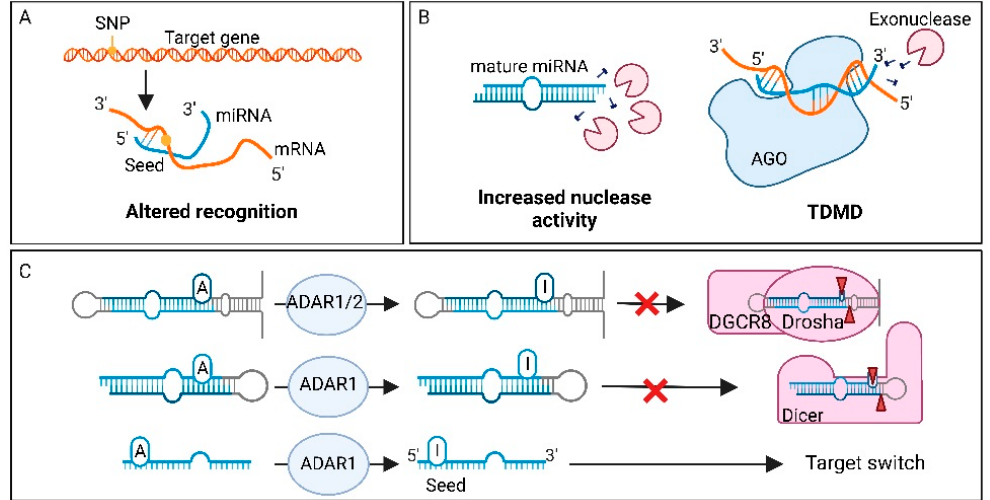
Figure 5. microRNA dysregulation in cancer through target gene modifications, and factors affecting microRNA degradation and microRNA editing. ( A ) A mutation in the microRNA (miRNA) recognition site of a target gene can result in multiple changes; the target can become undetectable for the miRNA, the mutation might change the degree of repression or make a target recognizable for miRNA. ( B ) miRNA stability in the cell is important for regulation of miRNA targets, and sta ‐ bility is lowered by increased nuclease activity or target ‐ directed miRNA degradation (TDMD). The latter process, TDMD, revolves around complementarity between target and miRNA. When a miRNA binds to its target with high 3 ′ end complementarity, the conformation of Argonaute (AGO) may change and the miRNA may become susceptible to degradation by exonucleases. ( C ) RNA editing, such as adenosine (A) to inosine (I) editing by adenosine deaminases acting on RNA 1/2 (ADAR1/2), can change the sequence of the RNA, with diverse consequences. miRNA editing can alter primary ‐ miRNA and pre ‐ miRNA in such a way, that they become unavailable for processing by ribonuclease III enzymes Drosha and Dicer, respectively. Additionally, the seed can also be ed ‐ ited, which allows for a shift in targetome, or altered recognition of existing targets (Created with